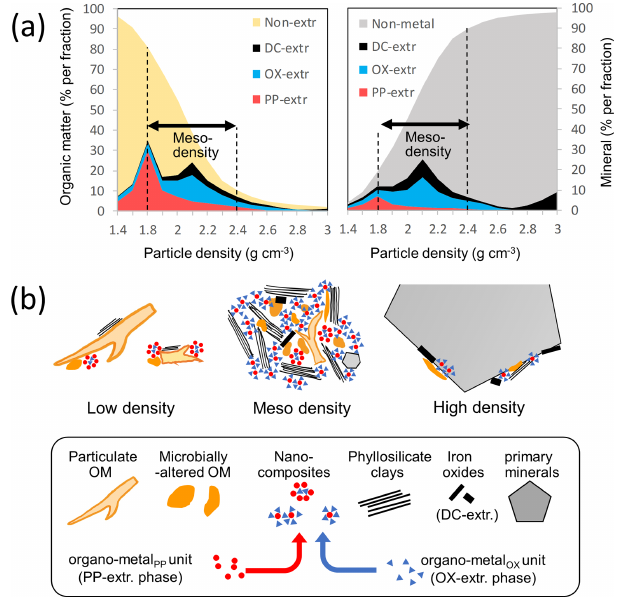
Figure 7. (a) Changes in the concentration of organic and mineral phases along soil particle gradient for an idealized soil. The con- centrations of OM (left plot) and metals (right plot) extracted se- quentially by pyrophosphate (PP), acid oxalate (OX), and dithion- ite (DC) per density fraction were shown in different colors. Non- extractable OM includes both particulate and microbially altered OM. Non-metal mineral phase includes phyllosilicate clays and pri- mary minerals. (b) Schematic representation of low-, meso-, and high-density particles (upper) and their building blocks (lower). PP- and OX-extractable phases were presumed to be present as “nanocomposites” that act as glue to form meso-density microag- gregates. The distribution of the nanocomposites across density fractions can explain the C:metal proportional relationship found in Figs. 3, A6, and A7. The nanocomposites rich in organo-metal PP unit are more abundant in OM-rich environments (e.g., lower- density fraction) relative to those rich in organo-metal OX units. Ob- jects do not reflect the size difference among